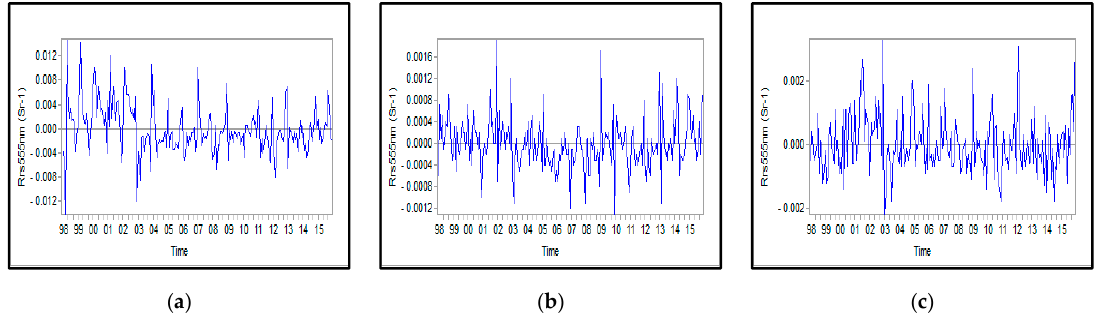
Figure A10. Monthly anomalies of Rrs_555nm for: ( a ) Northern, ( b ) Middle, and ( c ) Southern Caspian Sea.